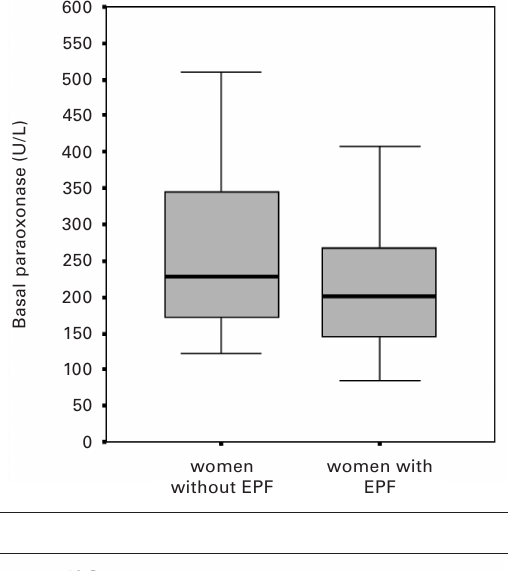
Increased serum LOOH levels in women with EPF in comparison with women without EPF ( p